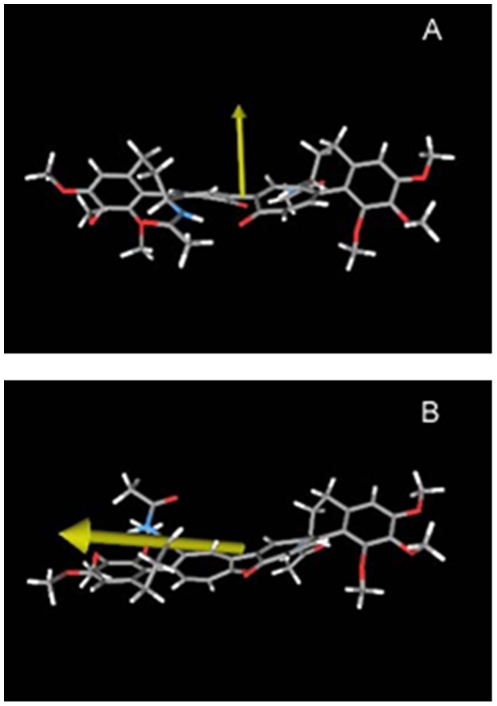
Geometry optimized structures of biisocolchicide atropisomers.The geometry optimized structures (level DFT/M05-2X/6-31G*, in vacuum) of biisocolchicide atropisomers (R
a,7S)(R
a,7'S)-5a (A) and (R
a,7S)(S
a,7'S)-5b (B) are shown. The yellow arrow indicates the direction of the dipole moment.